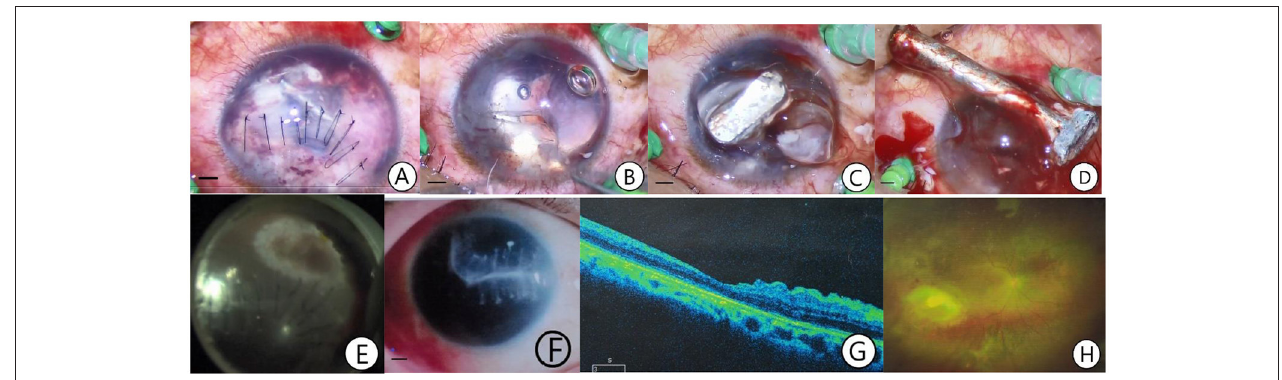
FIGURE 1 | A case of giant IOFB extracted from the entrance wound path. The patient was a 41-year-old man admitted to the hospital 8h after an eye injury caused by a nail. An emergency debridement and suture procedure were performed, and the combined second phase surgery of giant IOFB extraction from the entrance wound path, pars plana vitrectomy, retinectomy, retinal photocoagulation, and silicone oil tamponade was performed 24h after the injury (A–E) . The silicone oil was removed in 4 months. The retina was recovered with a scar formation at the retinal wound caused by the IOFB. A postoperative BCVA of 0.1 was achieved (F–H) . (A) One end of the giant IOFB was exposed after the infiltration and the cortex of the ruptured lens was removed. (B) The exposed IOFB end was visible after the wound sutures were removed. (C) After intraocular viscoelastic solution injection and loosening the giant IOFB from the intraocular tissue, the head of the IOFB floated out of the wound. (D) The giant IOFB was extracted through the entrance wound. (E) Retinal photocoagulation was performed at the site of the retinal wound due to the IOFB. (F) Corneal scar formation at the IOFB entrance wound. (G) Optical coherence tomography macular image after silicone oil removal. (H) Fundus photograph after silicone oil removal showing that the retina had reattached stably with a scar formed at the retinal wound site (The length of the bar: